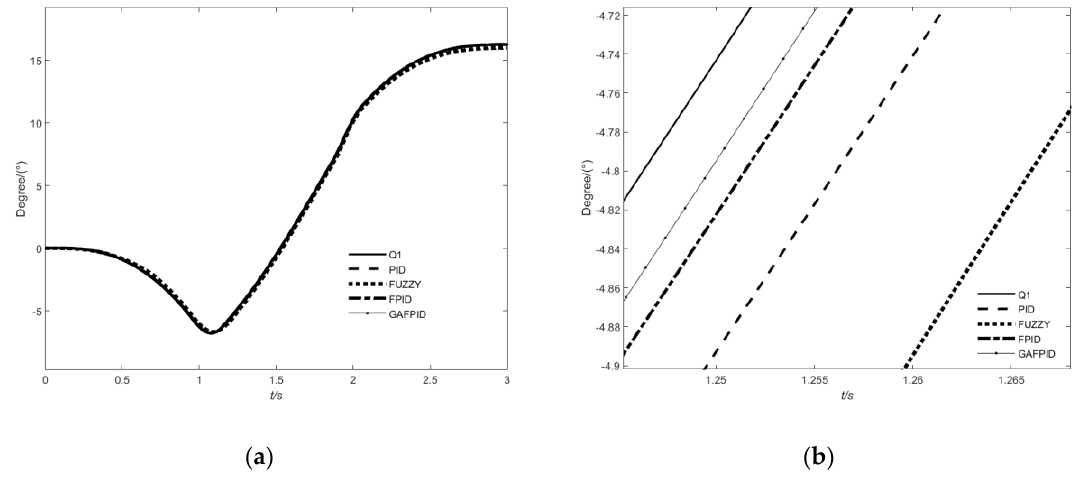
Figure 12. Joint trajectory Q1: ( a ) tracking response; ( b ) local enlarged view.